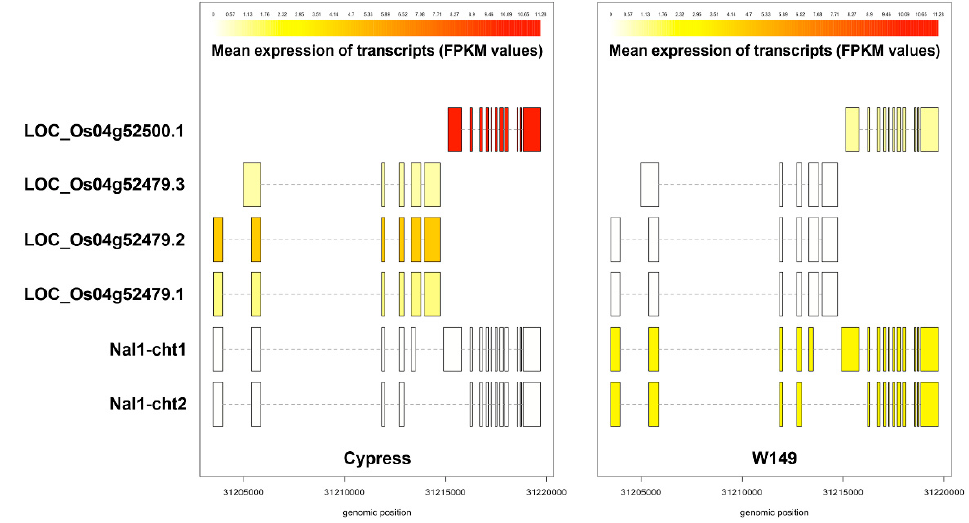
Figure 8. Transcripts identified in W149 and Cypress using Stringtie (v2.1.0). The LOC_Os04g52479.1 and LOC_Os04g52479.2 transcripts are ~2.6 kb in length while the LOC_Os04g52479.3 transcript is ~2.5 kb. The LOC_Os04g52500.1 is located downstream of the Nal1 gene with ~2.4 kb in length. The Nal1-chimeric transcript 1 (Nal-cht1) arises through splicing of the partial Nal1 -exon 4 ( Nal1 -ex4) of W149 to the exon 1 of LOC_Os04g52500.1, producing a transcript with a length of ~4.3 kb. The Nal1-cht2 arises when Nal1 -exon3 ( Nal1 -ex3) is spliced directly to the exon2 of LOC_Os04g52500.1, resulting in a ~3.2 kb transcript. The color shading represents the fragments per kilobase of transcript per million reads (FPKM) values of each transcript produced from Stringtie analysis. The transcripts were visualized using the R package